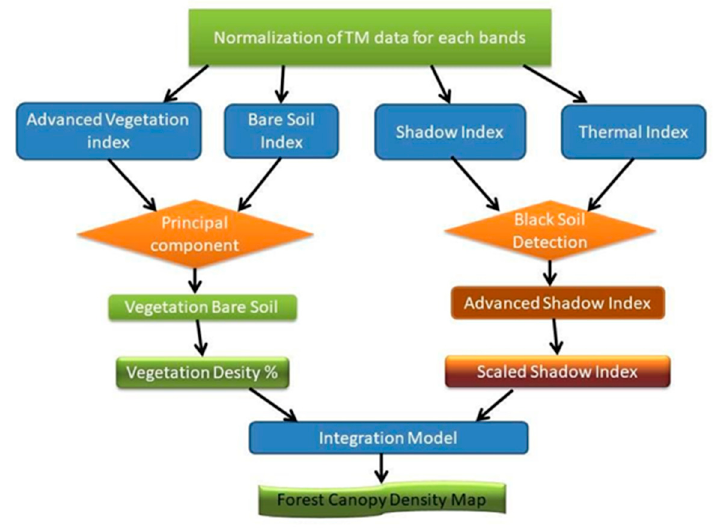
Figure 3. Flow chart of FCD mapping model.